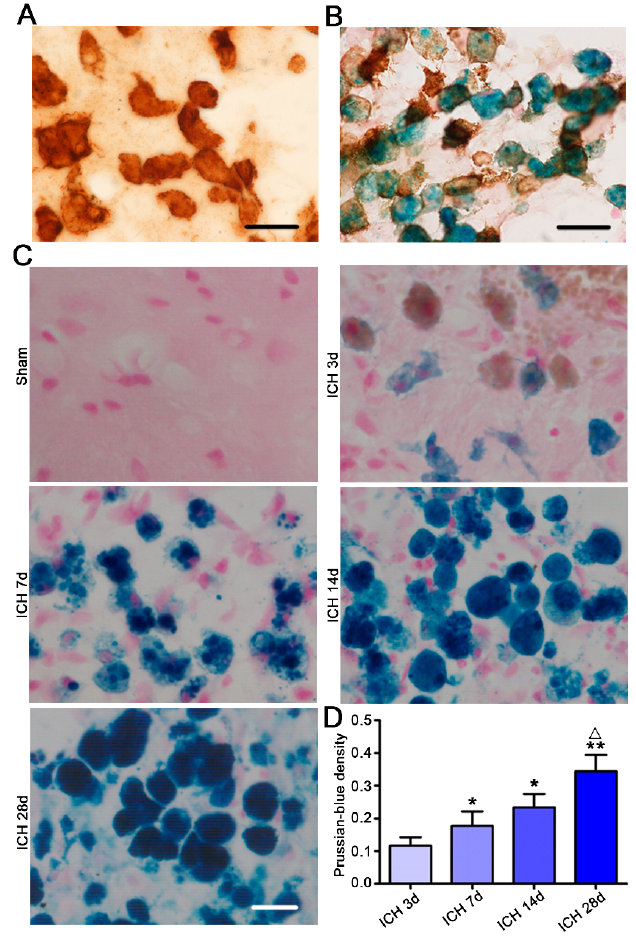
Figure 2. Ameboid microglia/macrophages in the hemorrhagic center presented Prussian blue positive. Brain slices (20 μ m) of intracerebral hemorrhage (ICH) rats were immunohistochemically stained by Iba-1 ( A , n = 5) or further double stained with Prussian blue ( B , C , n = 5). The optical densities of Prussian-blue staining were quantitatively analyzed in D ( n = 5). Microglia/macrophages in the brain slices taken at 7, 14 and 28 days had stronger blue staining than those in three-day brain slices ( C , D ). Bar = 25 μ m. Data were expressed as means ± SEM. * p < 0.05, ** p < 0.01, vs. ICH 3 d. Δ p < 0.05, vs. ICH 7 d.